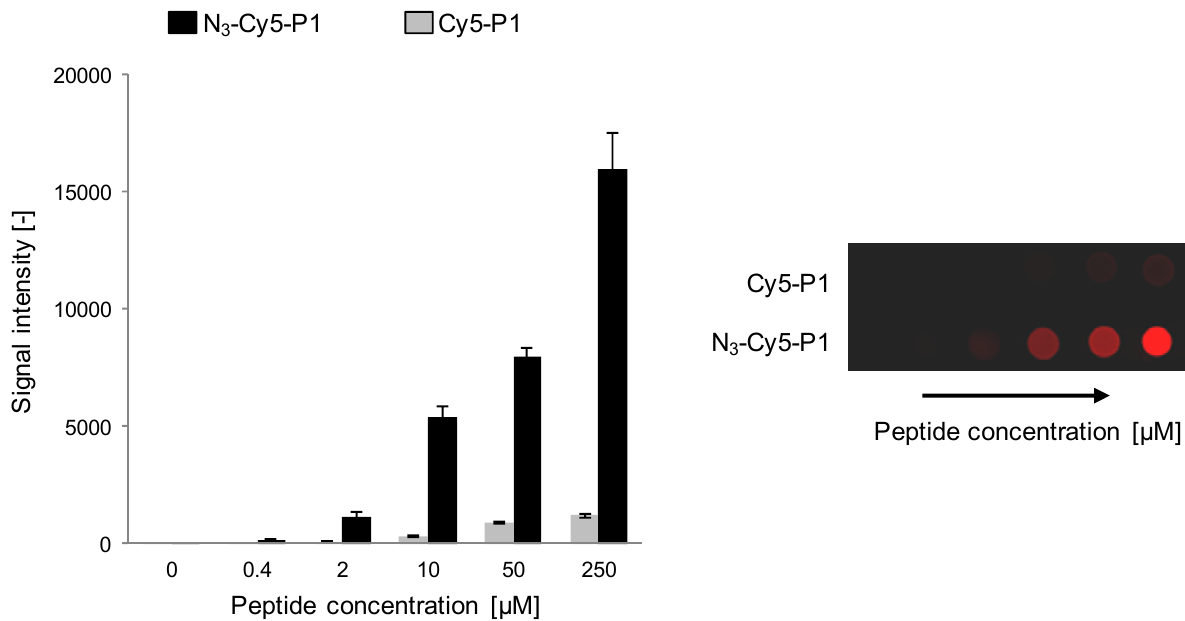
Figure 3. Immobilization reaction specificity of peptide N binding (NSB) of peptide Cy5-P1 to ADIBO-functionalized glass slides. 1 μ L of